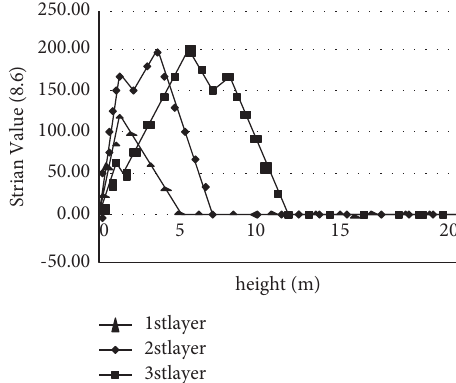
Figure 3: Strain variation of the first three layers of the